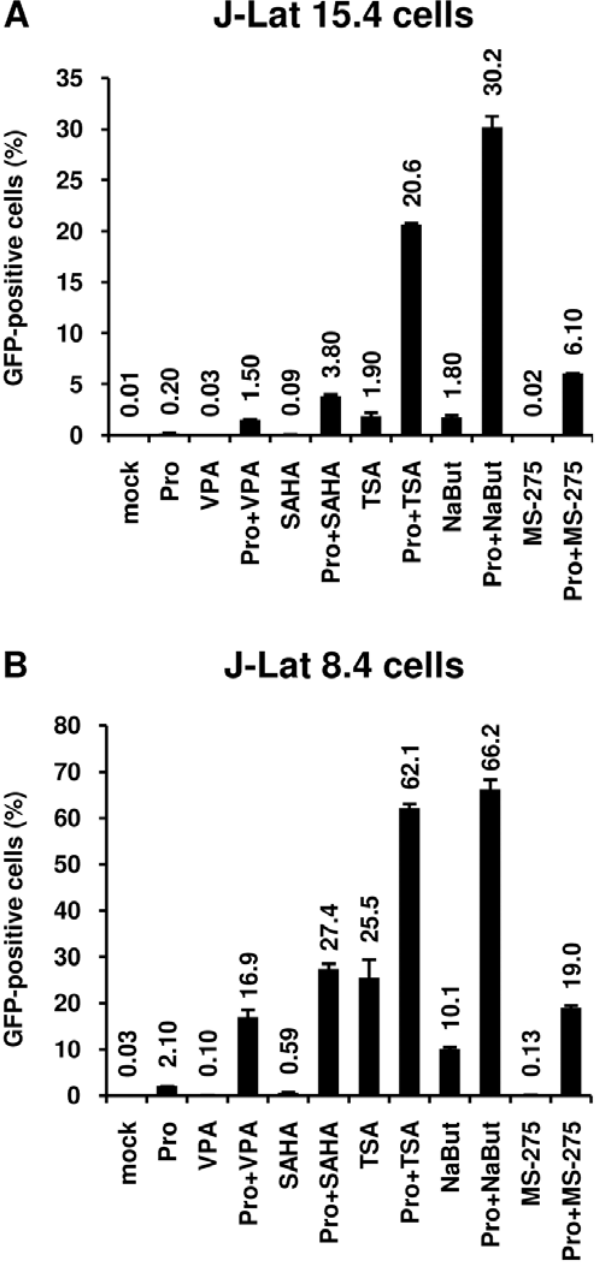
Figure 3. Prostratin + HDACI cotreatment induces HIV-1 expres- sion in a higher proportion of cells than the drugs alone. J-Lat 15.4 (panel A ) or 8.4 (panel B ) cells were mock-treated or treated with prostratin (5 m M), alone or in combination with different HDACIs [VPA (2.5 mM), SAHA (2.5 m M), TSA (500 nM), NaBut (5 mM) or MS-275 (5 m M)]. At 24 h posttreatment, cells were analyzed by FACS for GFP expression and results (percentage of GFP-positive cells) are represent- ed as histograms. Each value is the mean 6 SE from two